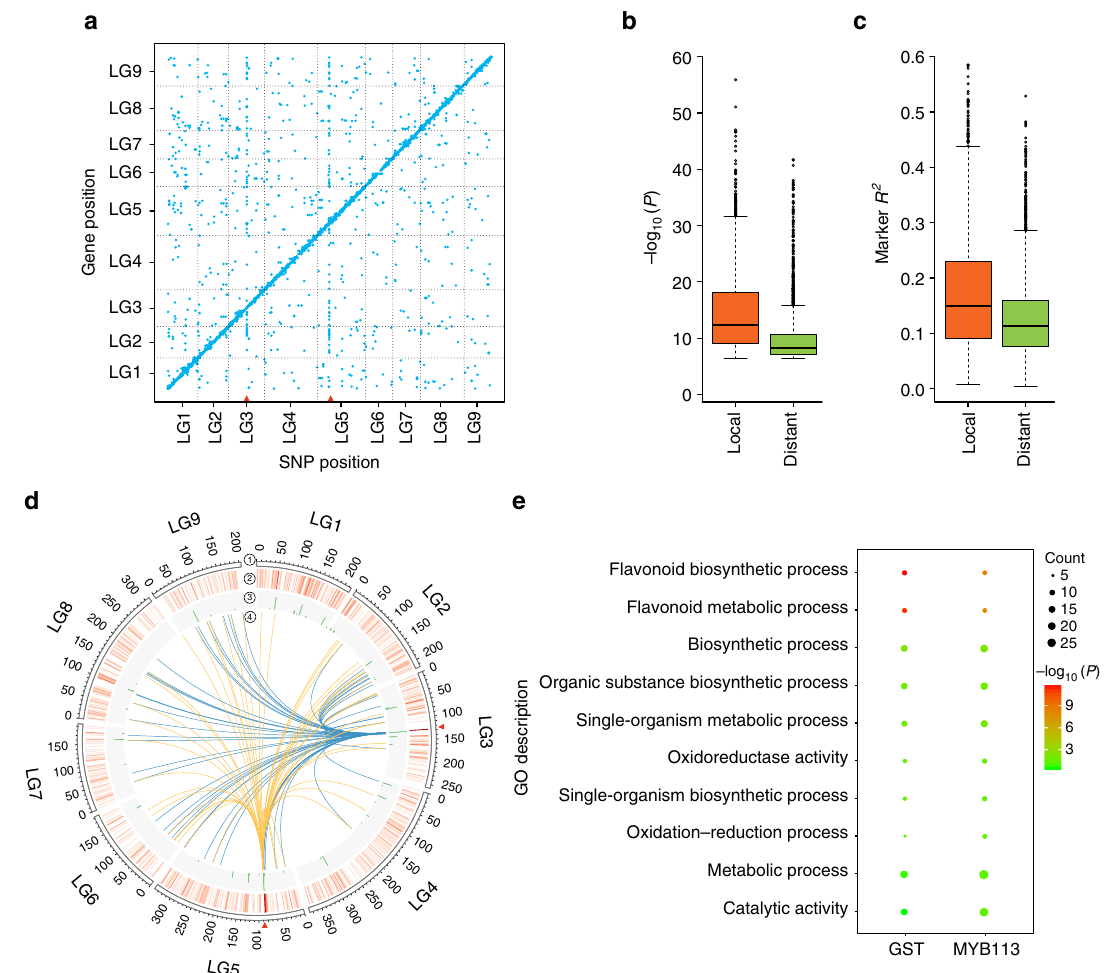
Fig. 4 Genome-wide mapping of eQTL. a eQTLs identi fi ed using GWAS. The middle position of each detected eQTL is plotted against the middle position of the mapped gene. The x -axis indicates the positions of the eQTLs and the y -axis indicates the positions of the mapped genes. Each dot represents a detected eQTL. Two red triangles indicate the two most signi fi cant distant eQTL hotspots, each of which are eQTLs of dozens of genes. b Boxplots of the − log − log 10 ( P ) values of local and distant eQTLs. The median value of 10 ( P ) is 12.37 and 8.28 for local and distant eQTLs, respectively. c Boxplots of the effects of local and distant eQTLs. The median value of effect is 14.99% and 11.34% for local and distant eQTLs, respectively. d Visualization of distant eQTL hotspots using Circos 69 . Two red triangles on chromosomes 3 and 5 indicate the two most signi fi cant distant eQTLs. 1 Nine chromosomes of lettuce. 2 Heatmap that showing the counts of targets in a 2 Mb window across the genome. 3 Histogram that showing the signi fi cance (calculated by − log 10 ( P value)) of each distant hotspot. 4 Links between the two most signi fi cant distant eQTL hotspots and their target regions. e GO enrichment analysis of target genes of GST and MYB113 ,